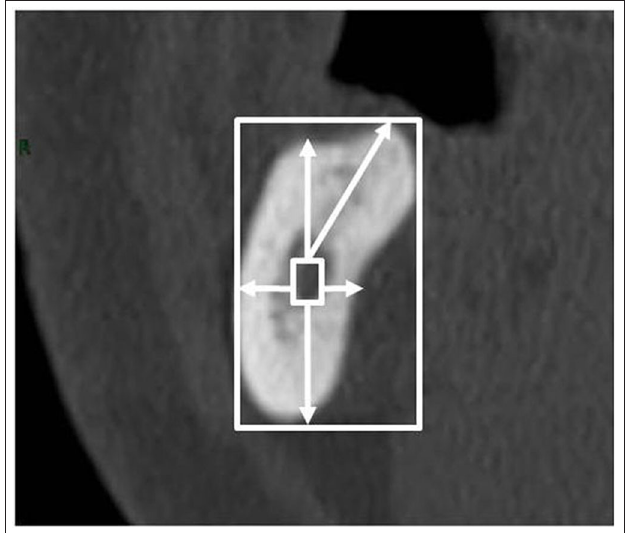
Fig. 1. Central coronal MDCT slice showing the measurements of the mandibular canal and mandibular bone. Data were analyzed using the SAS 9.1 software (SAS Institute, Cary, NC, USA). Descriptive parameters were given as mean and standard deviation (SD). Significant differences between comparable measurements were tested for gender and classes of the edentulous jaws with Fisher’s exact test.